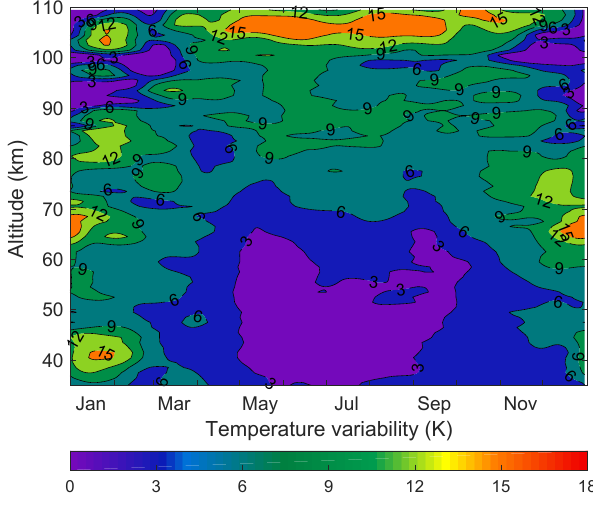
Figure 4. Geophysical variability in temperature for the OEM PCL climatology.